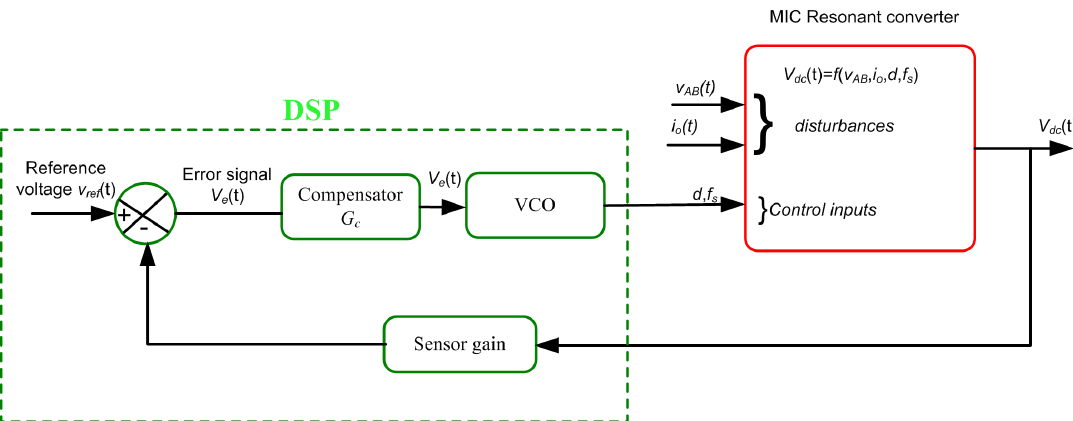
Figure 6. Control